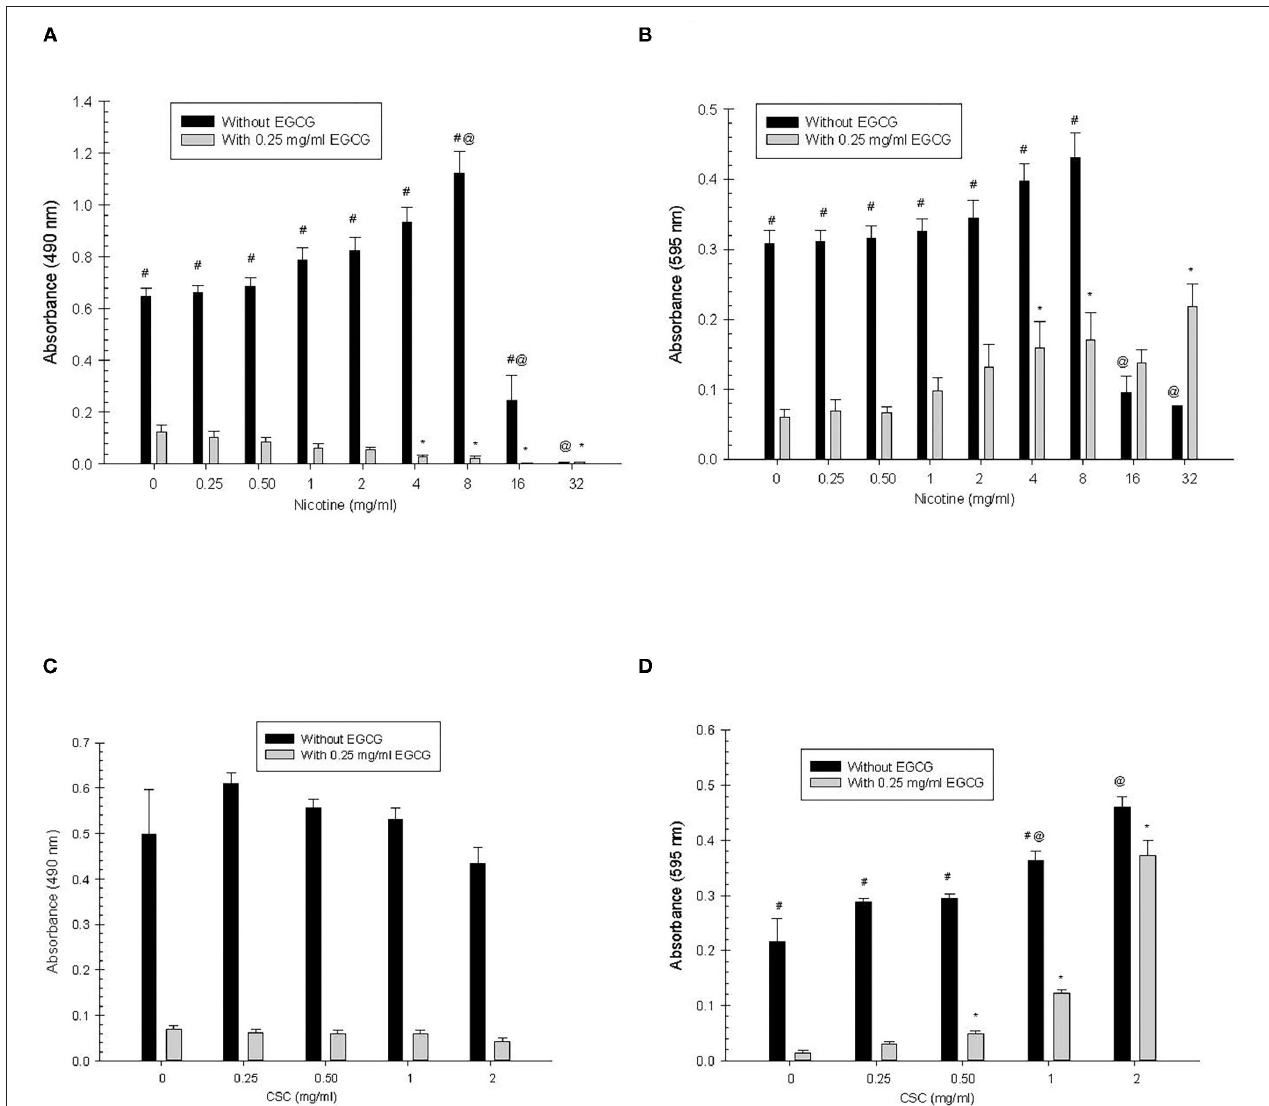
FIGURE 1 | Primary S. mutans biofilm (A,C) and total absorbance (B,D) nicotine/CSC exposure effects. # Indicates significant differences between growth with 0.25 mg/ml of EGCG and without EGCG. * and @ indicates significant differences between 0 mg/ml nicotine/CSC and other concentrations with 0.25 mg/ml of EGCG and without EGCG,